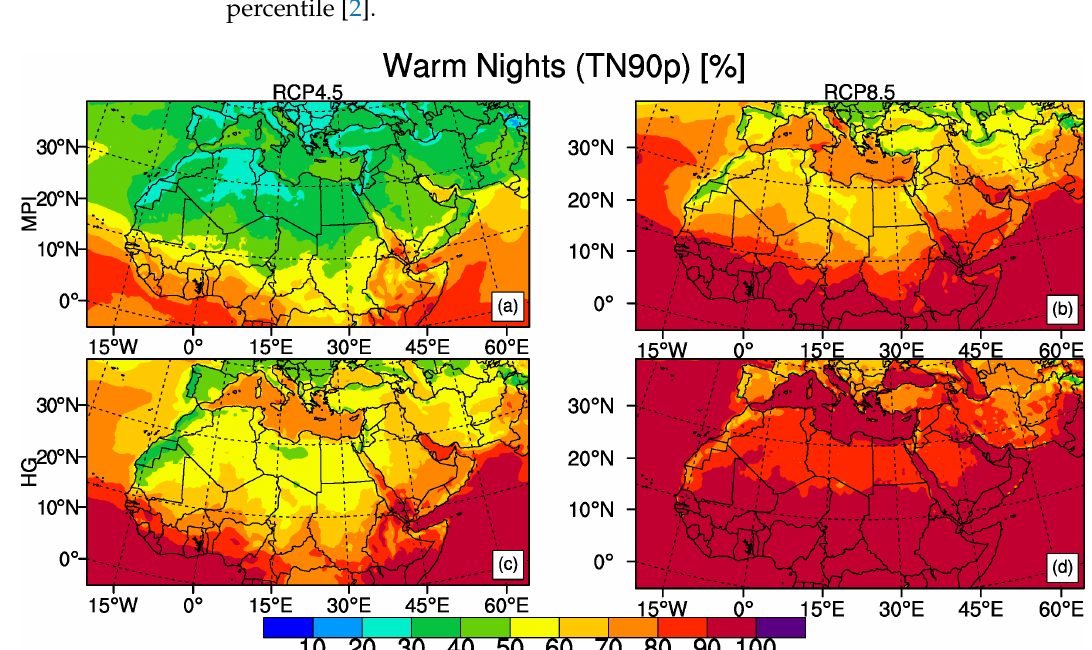
Figure 8. Annual frequency of TN90p temporally averaged over the period of 2071–2100 as absolute values of the exceedance rate (in %) for the model MPI-ESM-MR with RCP4.5 ( a ) and RCP8.5 ( b ) and for the model HadGEM2-ES with RCP4.5 ( c ) and RCP8.5 ( d ). By definition, the exceedance rate averages to approximately 10% over the reference